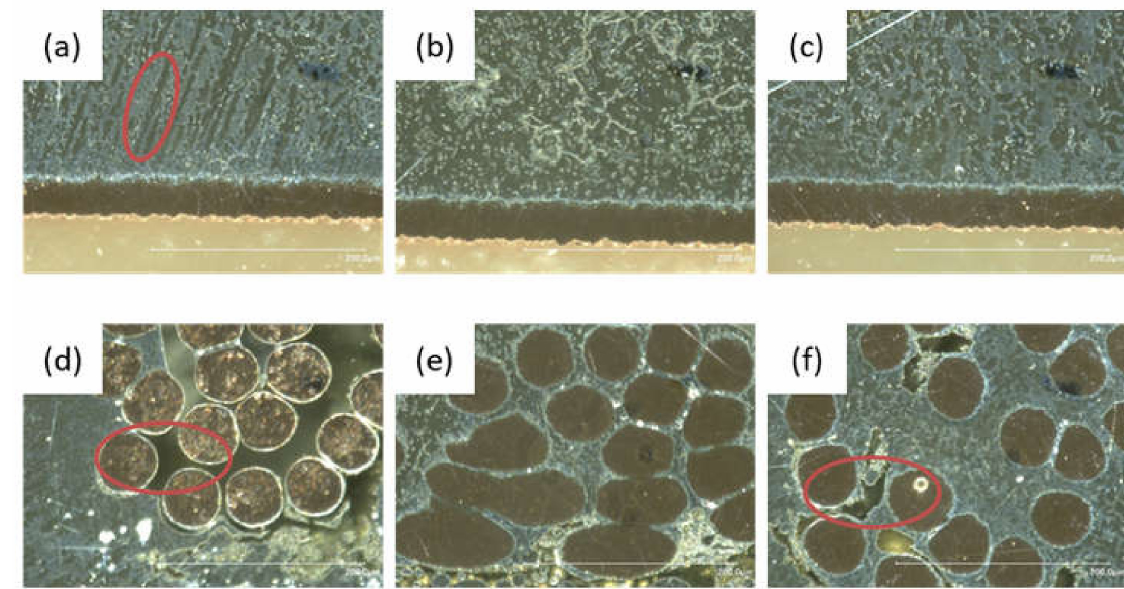
Figure 4. Microsections of various solder materials, ( a , d ) Sn95.5Ag3.8Cu0.7 with a needle-shaped microstructure in picture ( a ) marked with a red circuit, ( b , e ) Sn99.7Cu0.3, ( c , f ) Sn97Ag3; ( d , f ) not completely wetted electrical conductors also marked by red